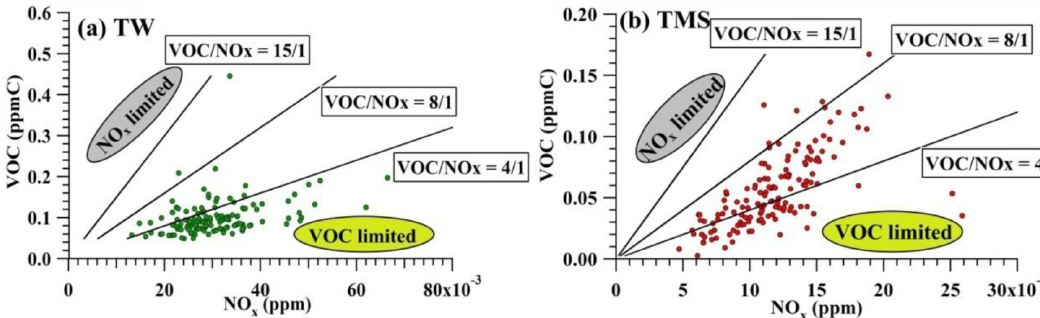
Fig. 12. Scatter plots of VOCs vs. NO x at daytime hours (07:00–18:00LT) during sampling period at (a) TW and (b) TMS.